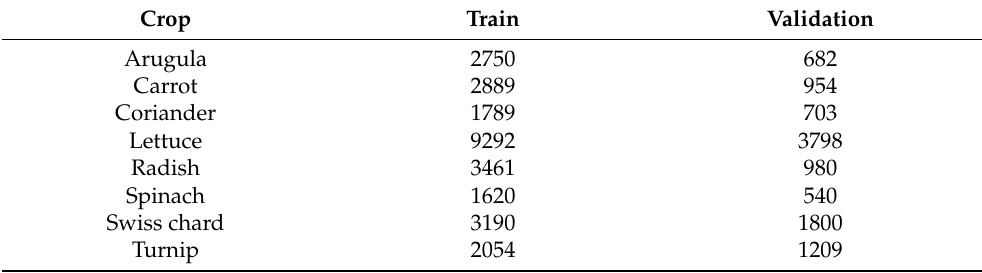
Table 4. Training and validation image sets’ composition after the data augmentation step, consider- ing only RGB